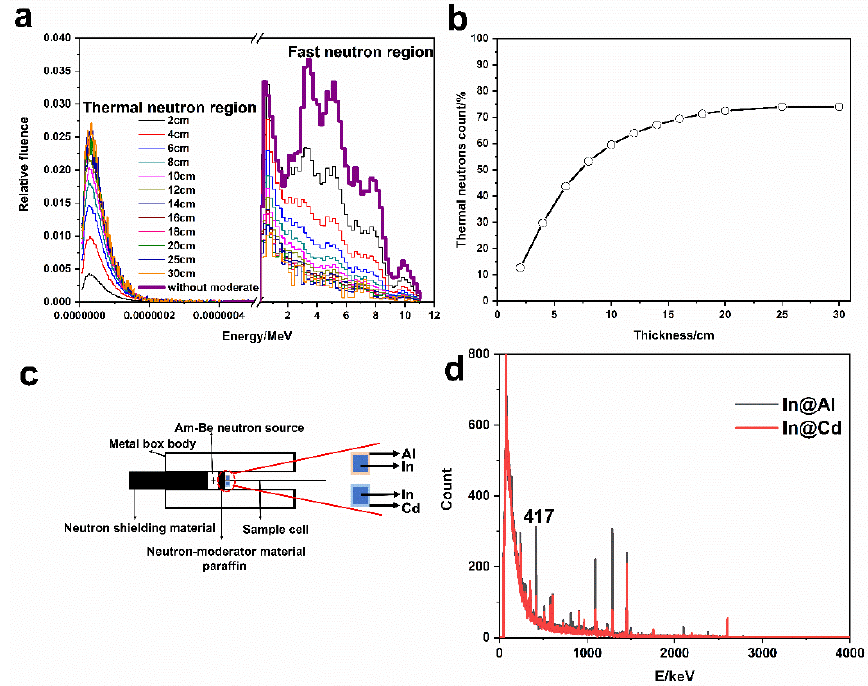
Figure 8. Neutron energy spectrum at different thicknesses of moderator ( a ), proportion of thermal neutrons in total neutrons ( b ), diagram of experimental apparatus for measuring neutron flux rate by activation method ( c ), and gamma spectrum of activated In sheet covered by Al and Gd, respectively ( d ).